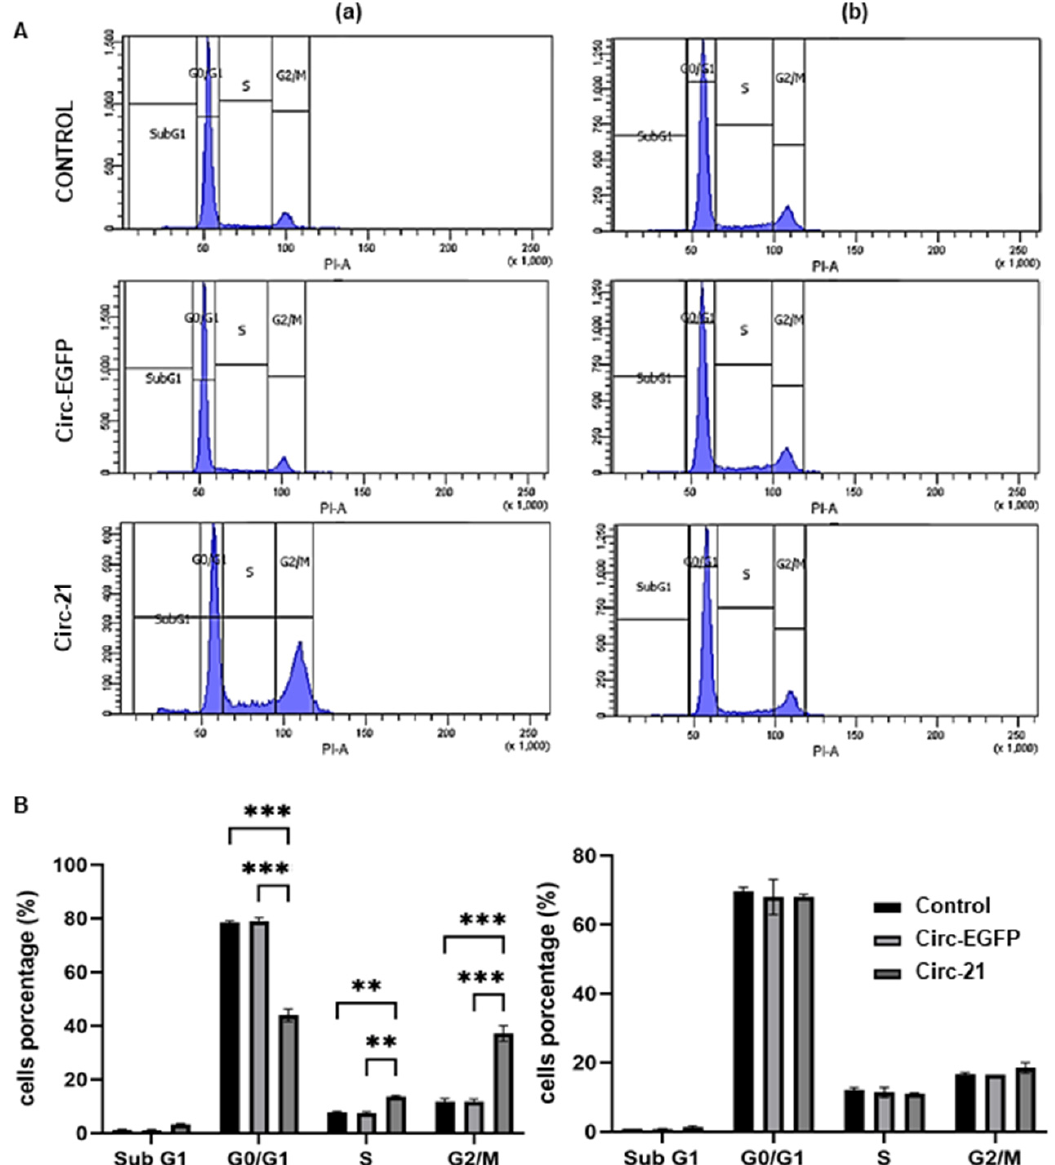
Figure 6. The cell cycle analysis of the MCF7 (a) and MCF10A (b). ( A ) Images of the FACScan flow cytometry results from cells exposed to PI/RNAse. ( B ) A graphic representation of percentage of labeled cells in each cell cycle phase. Cell cycle modification was only observed in the MCF7 cells, where the Circ-21 caused detection in G2/M. Values represent means ± SD ( n = 2). ** p < 0.01 and *** p < 0.001.